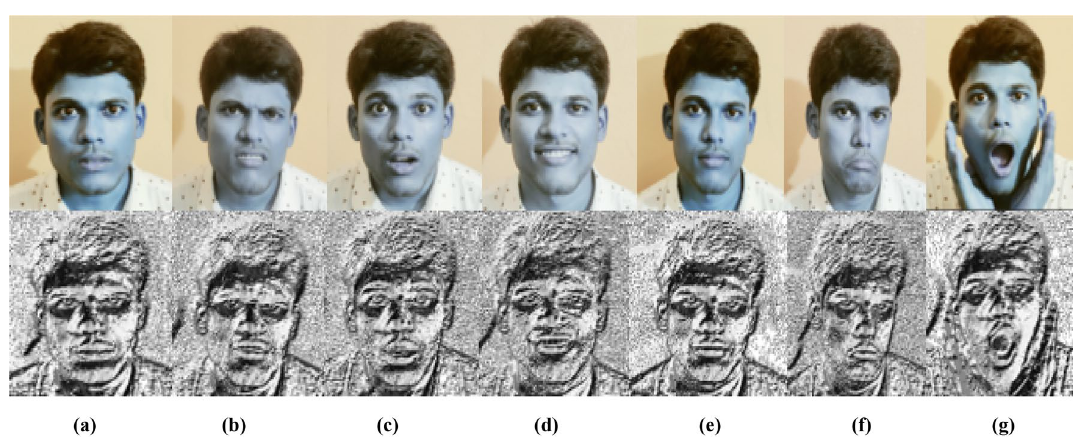
Figure 14. Original LBP features of facial expressions. ( a ) Happy ( b ) Angry ( c ) Fear ( d ) Sad ( e ) Disgust ( f ) Surprise ( g ) Neutral. . (Figure adapted from our own test images 39